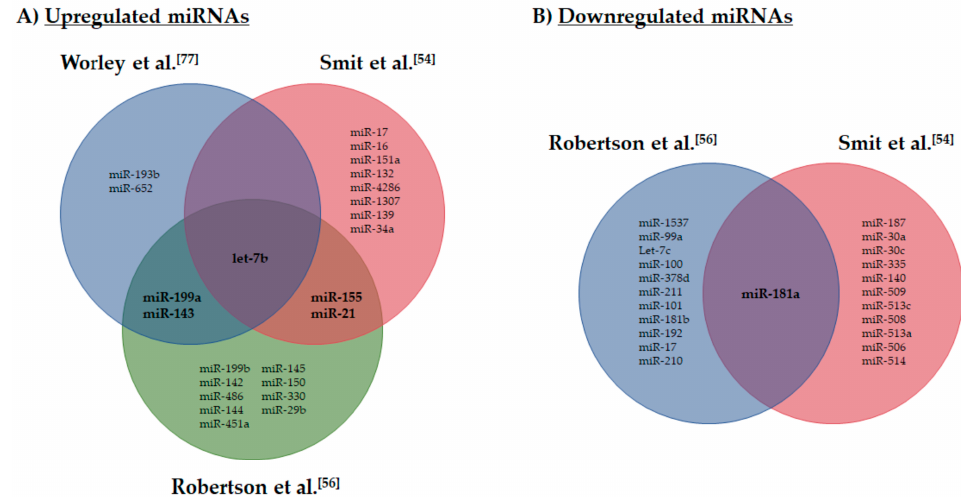
Figure 1. MicroRNAs (miRNAs) associated with an increased metastatic risk in uveal melanoma (UM). Evaluation of miRNA commonality was undertaken between three studies examining miRNA expression de novo in large well-defined UM sample sets. ( A ) Venn diagram of upregulated miRNAs associated with an increased metastatic risk. ( B ) Venn diagram of downregulated miRNAs associated with an increased metastatic risk. The miRNAs included in this analysis were obtained from Worley et al. (only upregulated miRNAs reported), Robertson et al. (miRNAs comparing cluster 3 + 4 with 1 + 2, fold change > 2) and Smit et al. (all miRNAs found in high and low / intermediate metastatic risk comparisons). Overlapping miRNAs are in bold font and commonalities are identified for the upregulated miRNAs et-7b, 199a, 143, 155 and 21, and for the downregulated miRNA 181a. Only the mature miRNA identifiers were used within this comparative analysis.